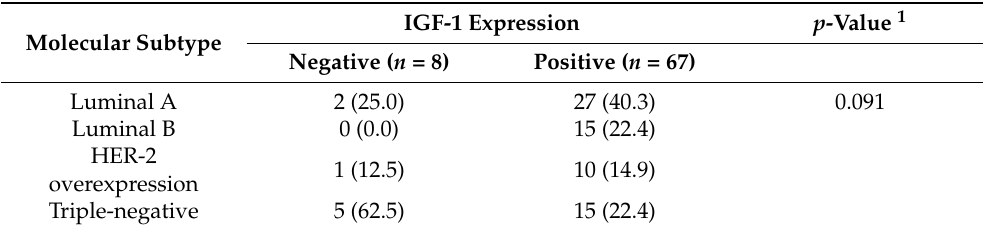
Table 5. Association of IGF-1 expression with breast carcinoma molecular subtypes in young patients ( n = 75).